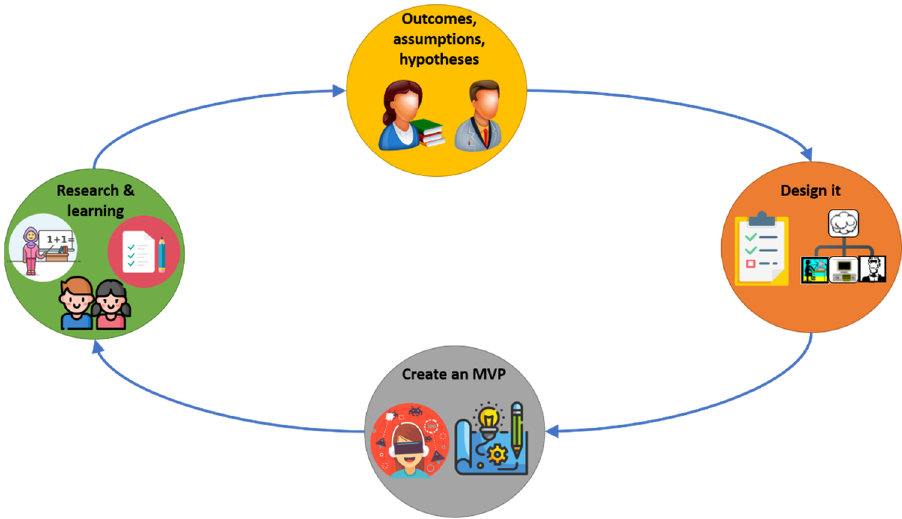
Figure 1. Lean UX Model for the production of virtual reality environments for users with ADHD (reprinted of Gothelf’s model) [35]).